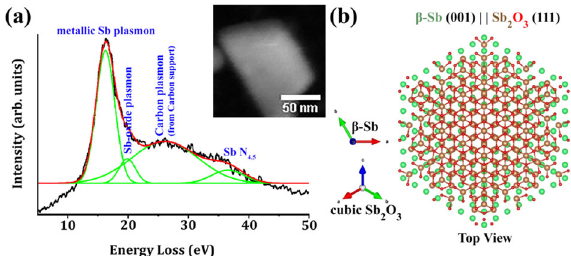
Fig. 4 Oxidation. a VEELS spectrum of the β -Sb(001) crystal on suspended graphene (on amorphous carbon support) in the ADF STEM in the inset. The spectrum was acquired after ~8 months ambient air exposure of the sample. The VEELS data are fi tted to the components labeled and described in the main text. Measurements on multiple β -Sb(001) and β -Sb[2-21]/cubic Sb(001) deposits showed similar results in terms of only low Sb-oxide plasmon signal. Note that the metallic Sb plasmon has the same energy for β -Sb(001) and β -Sb[2-21]/cubic Sb(001) in our VEELS measurements 96 . b Atomic model of the suggested Sb 2 O 3 (111)|| β -Sb(001) heterostructure that forms from ambient air exposure on β -Sb(001)